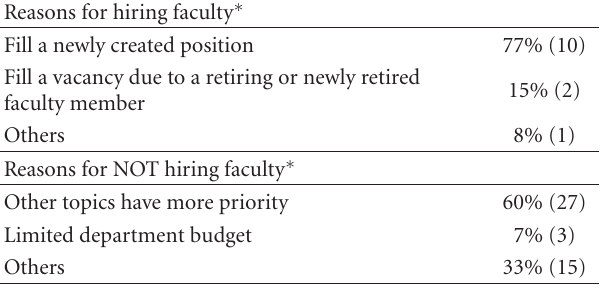
Table 7: Reasons for corrosion faculty recruitment.